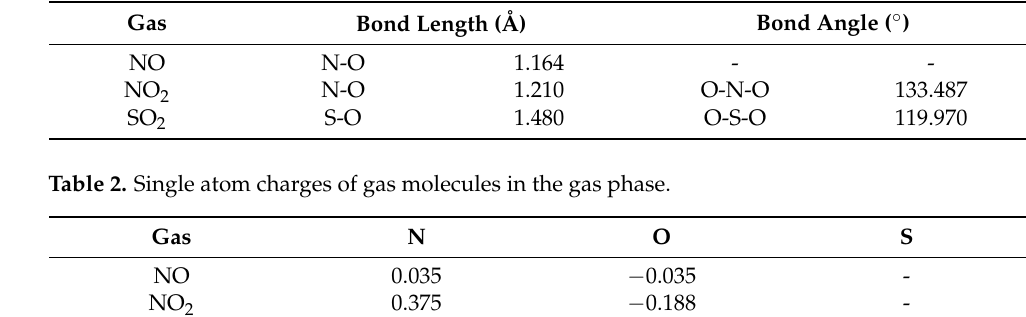
Figure 1. Optimized configuration of ( a ) C 3 N monolayer, ( b ) NO, ( c ) NO 2 and ( d ) SO 2 . Table 1. Geometrical parameters of NO, NO 2 and SO 2 .